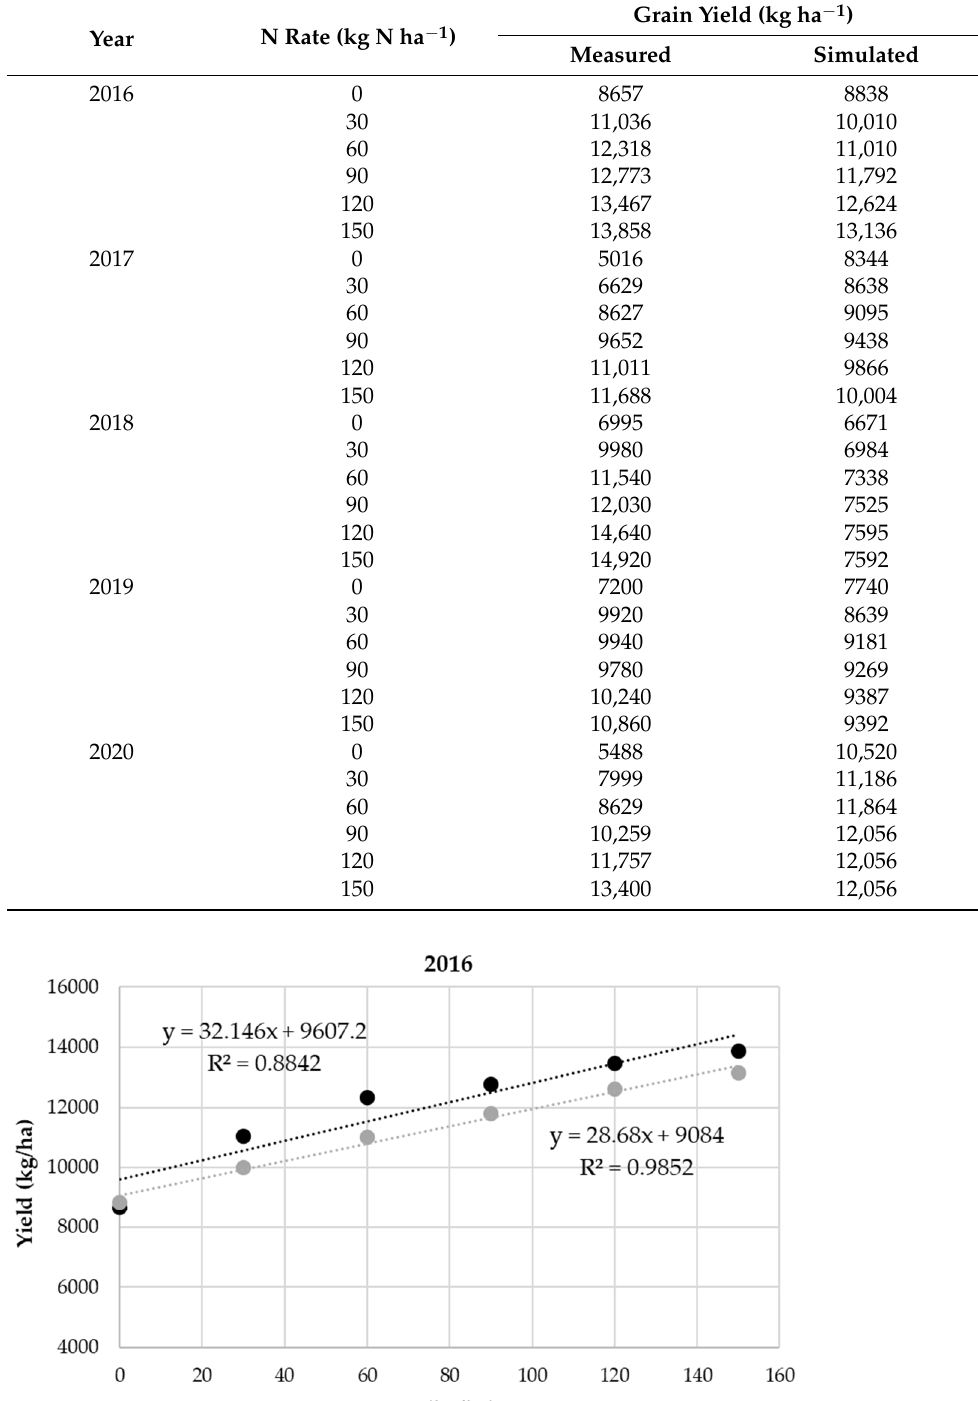
Table 8. Measured and simulated yields of Sushi maize hybrid (2016–2020).